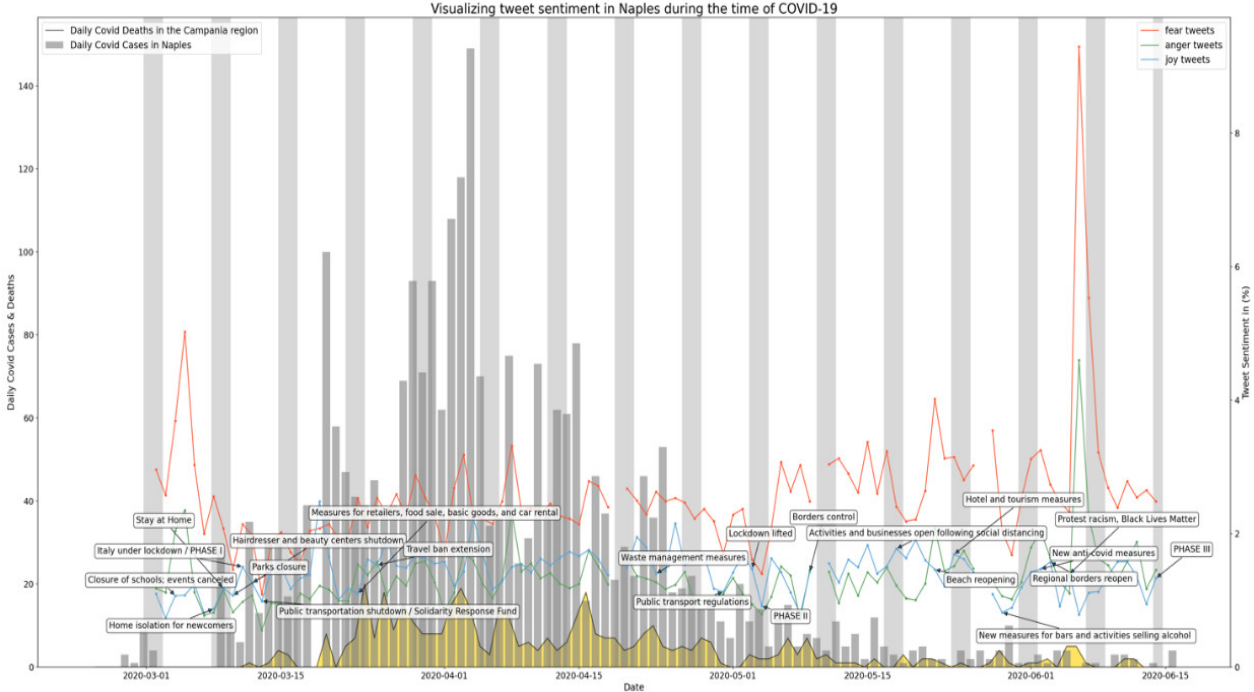
Figure A7. Visualizing Twitter sentiment in Naples during the time of COVID-19. With regard to fear, users on Twitter produced the highest number of tweets express- ing fear in the month of June with 3.85% of the total collected tweets when compared to May with 2.56%, April with 2.42%, and March with 2.16%, respectively. Naples Twitter users displayed a total average of 2.38% tweet frequency related to fear.